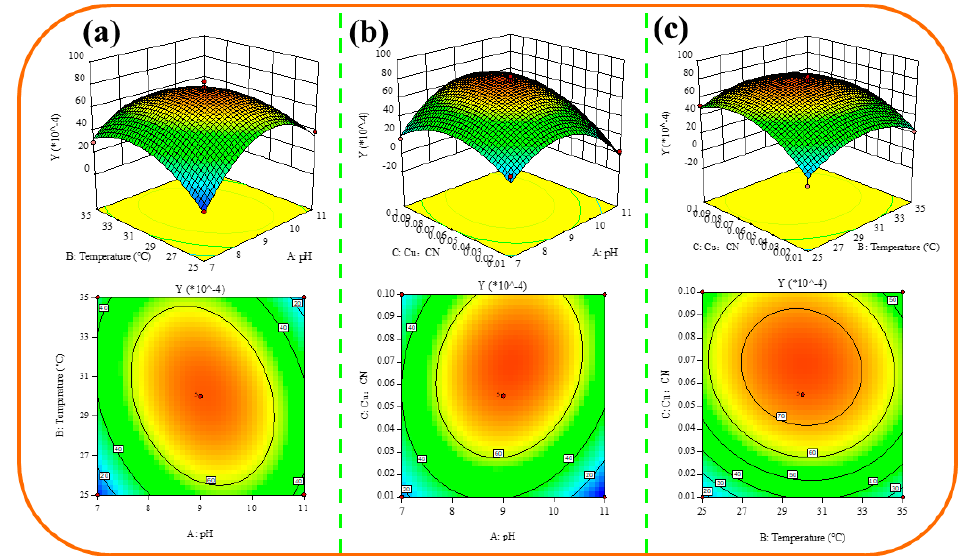
Figure 8. ( a ) Effect of pH and temperature interaction on Cu(CN) 43 − . ( b ) Effect of interaction between pH and c Cu : c CN on Cu(CN) 43 − . ( c ) Effect of interaction between temperature and c Cu : c CN on Cu(CN) 43 − .